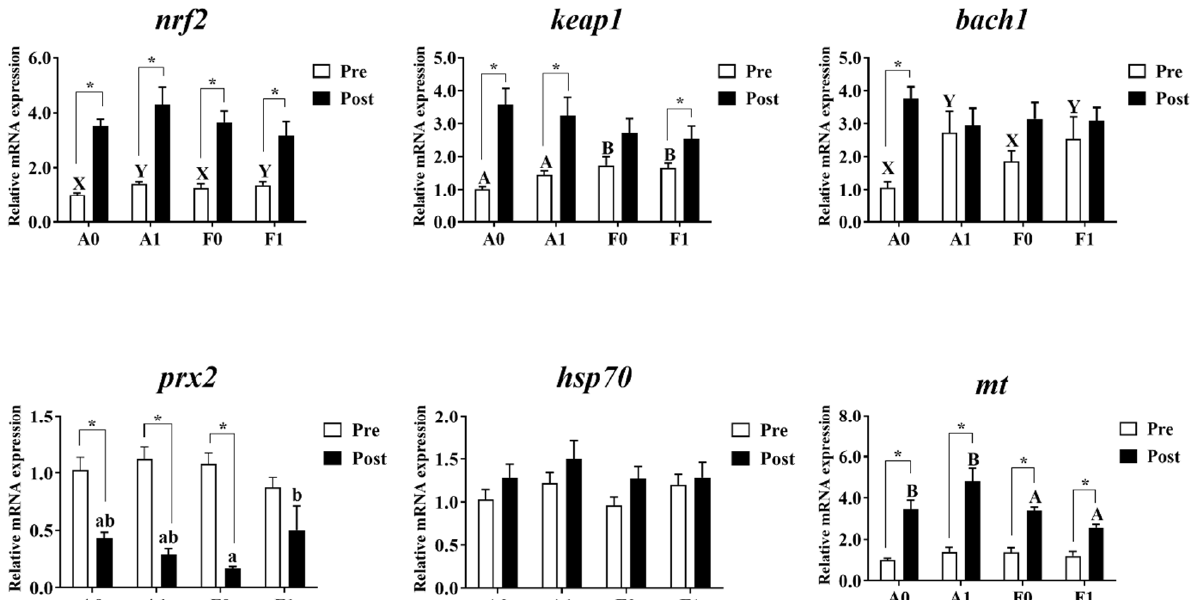
Figure 6. Expression levels of genes related to antioxidation and metallothionein ( mt ) in the livers of gibel carp (A and F strains) before cadmium exposure (white bars) and after cadmium exposure (black bars). A0: A strain fed the control diet; A1: A strain fed a diet supplemented with taurine; F0: A strain fed the control diet; F1: A strain fed a diet supplemented with taurine. Bars with different uppercase letters (A, B) represent significant differences between the A and F strains ( p < 0.05). Bars with different uppercase letters (X, Y) represent significant differences between the control diet group and the taurine diet groups ( p < 0.05). Bars with different lowercase letters (a, b) indicate a significant interaction effect and represent the differences among all the groups ( p < 0.05). Bars with * indicate significant changes between before and after cadmium exposure ( p < 0.05).